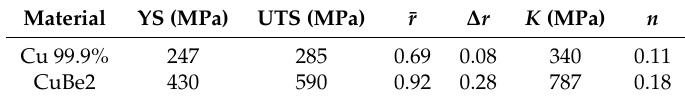
Table 2. Mechanical properties of the sheet materials. YS: Yield Stress, UTS: Ultimate Tensile Stress,